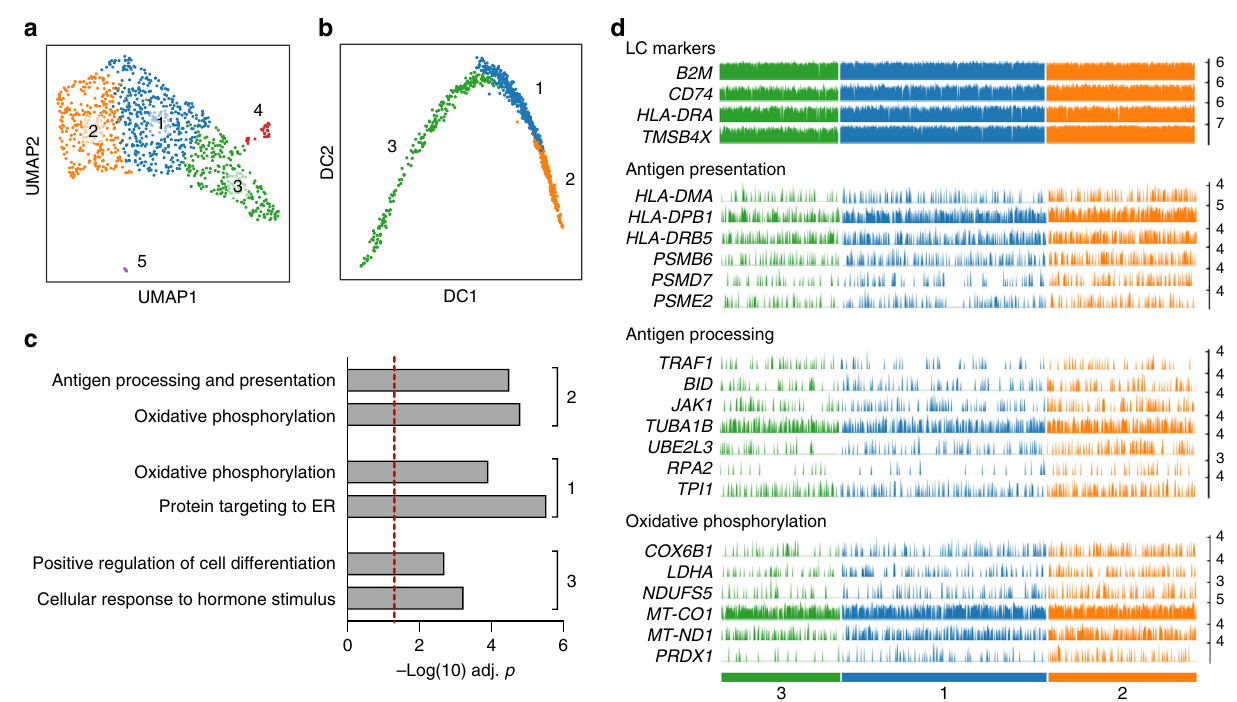
Fig. 3 scRNA-seq analysis of migrated human LCs. a UMAP plot of 950 migrated LCs (ScanPy, Leiden r = 0.2, n_pcs = 4, n_neighbours = 10, 2464